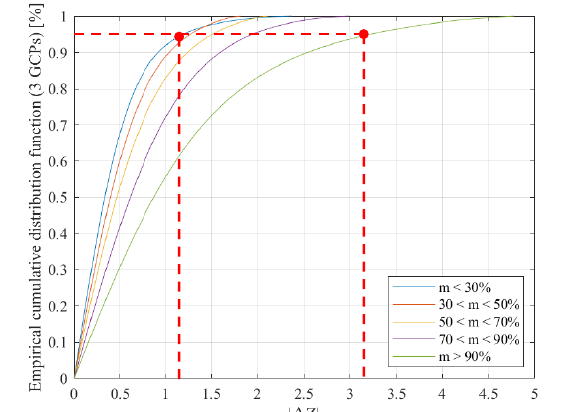
Figure 12 – Empirical cumulative distribution function of | D Z| for different categories of slope (m) calculated over more than 21M points